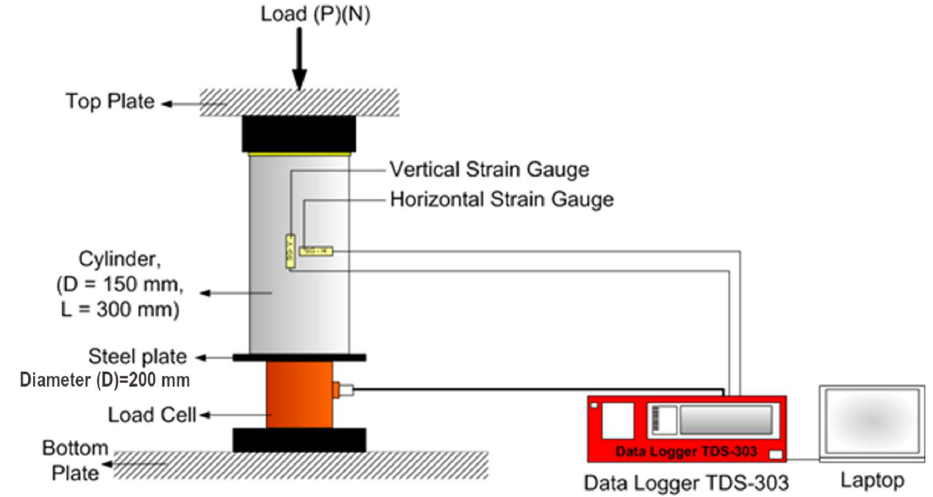
Figure 1. Test setup for compressive strength and elasticity modulus.